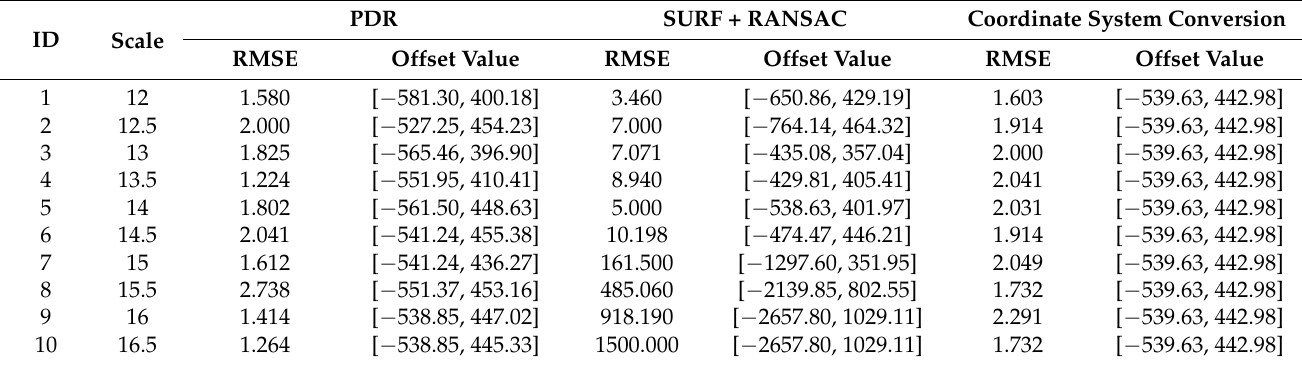
Table 6. Registration results of three methods in vector maps of Shaxi.